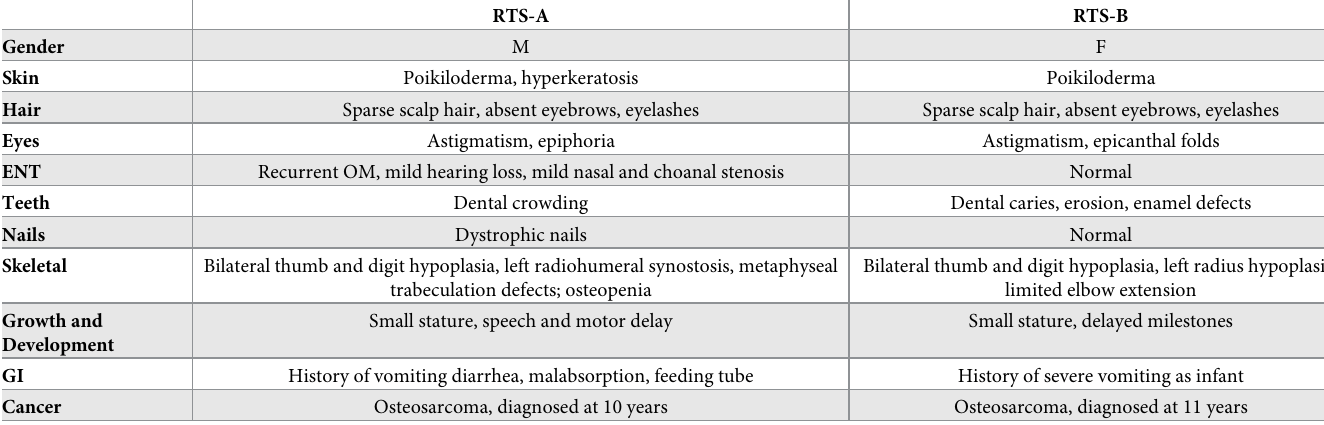
Table 1. Clinical characteristics of RTS Type 2 individuals with RECQL4